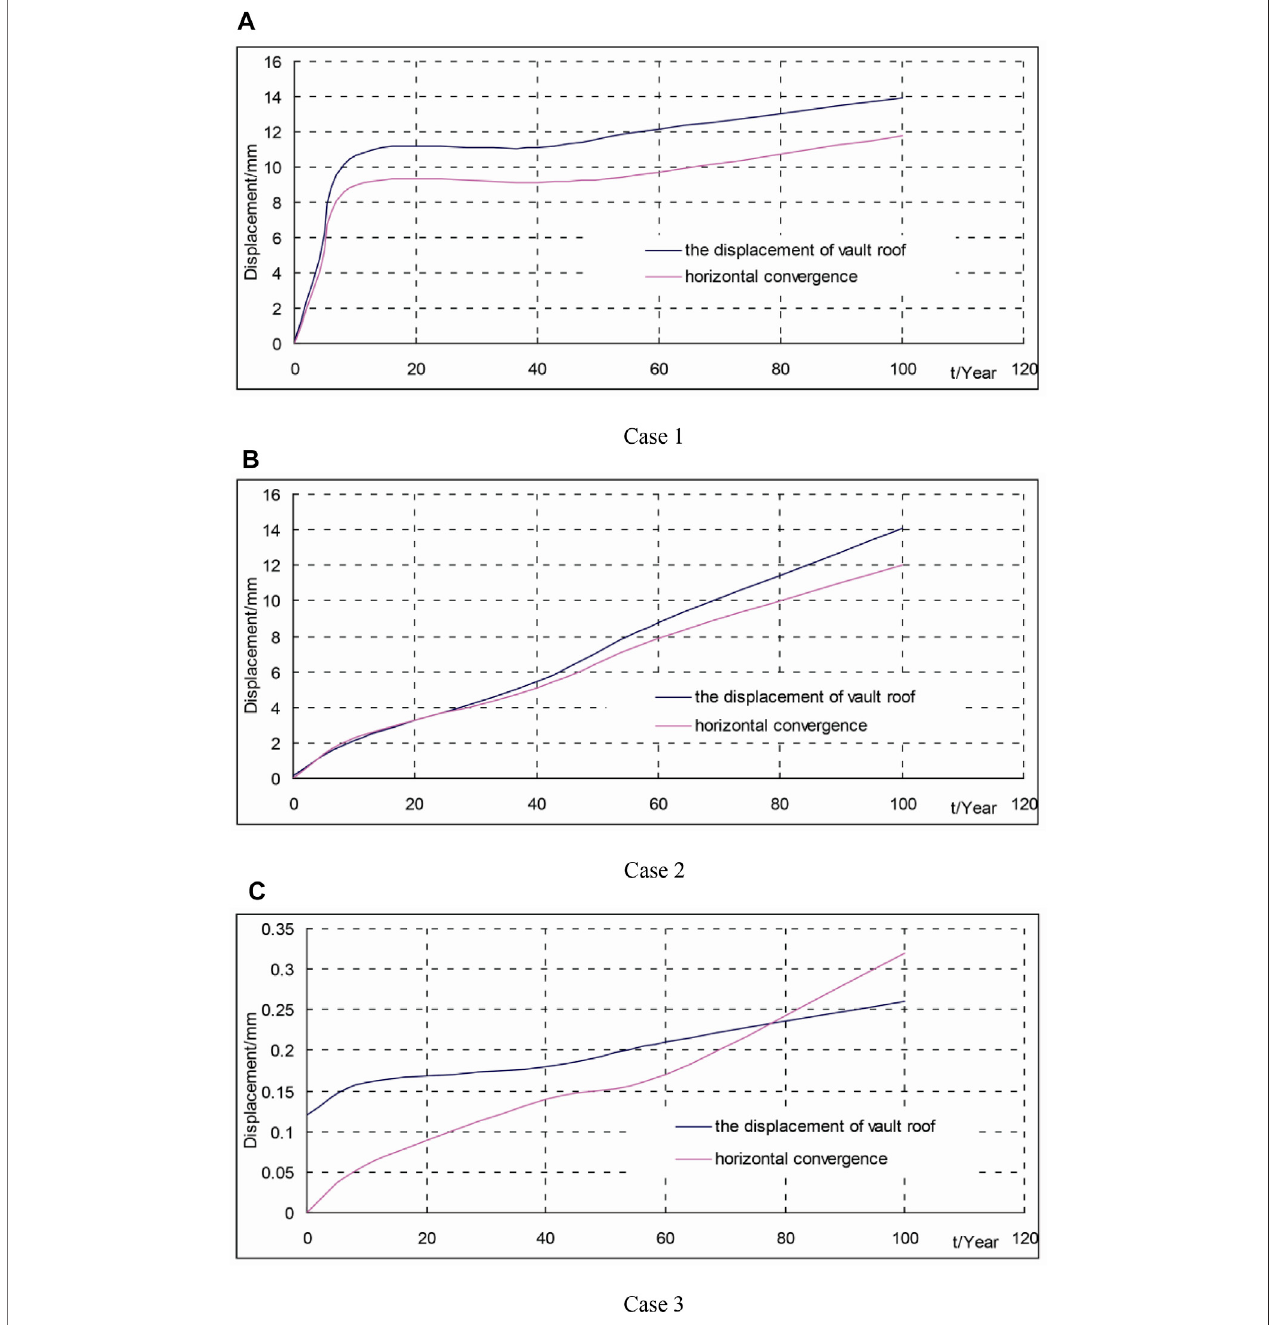
FIGURE 7 | Variations in the displacement of the secondary lining with time. (A) Case 1. (B) Case 2. (C) Case